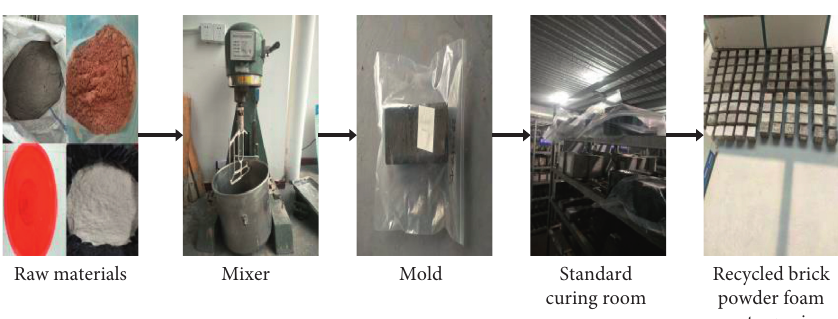
Figure 5: Test piece preparation process for recycled brick powder foam